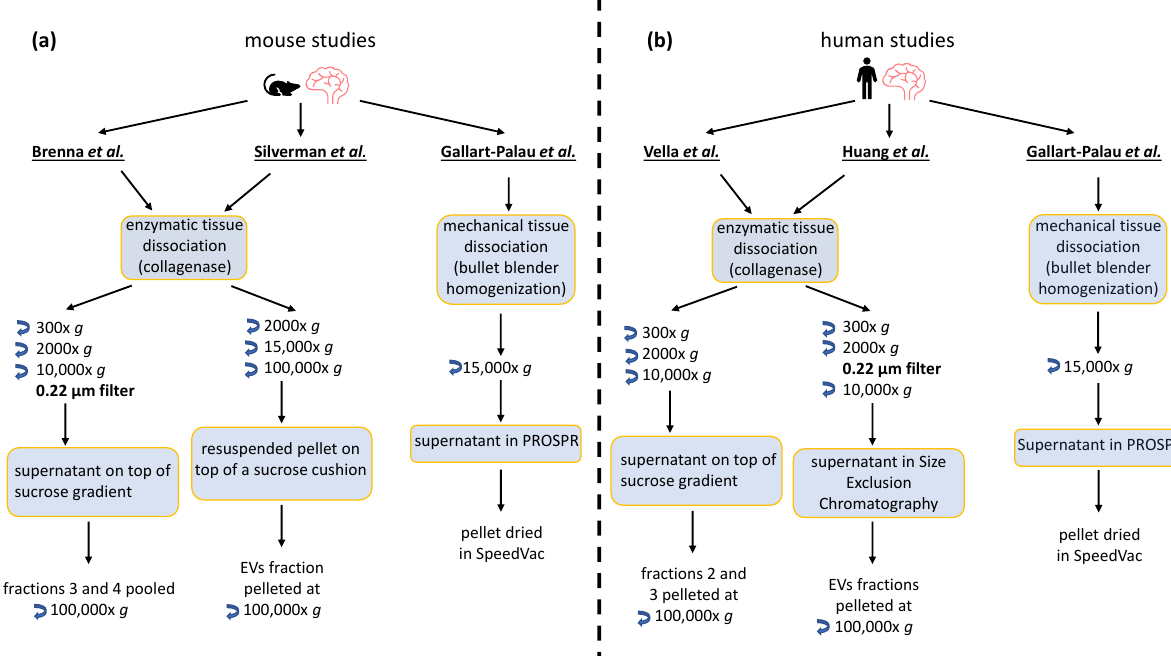
Figure 1. Summarizing scheme comparing protocols used for the proteomics analysis of BDEVs. ( a ) Schematic workflow of the protocols used in the mouse studies. ( b ) Schematic workflow of the protocols used in human